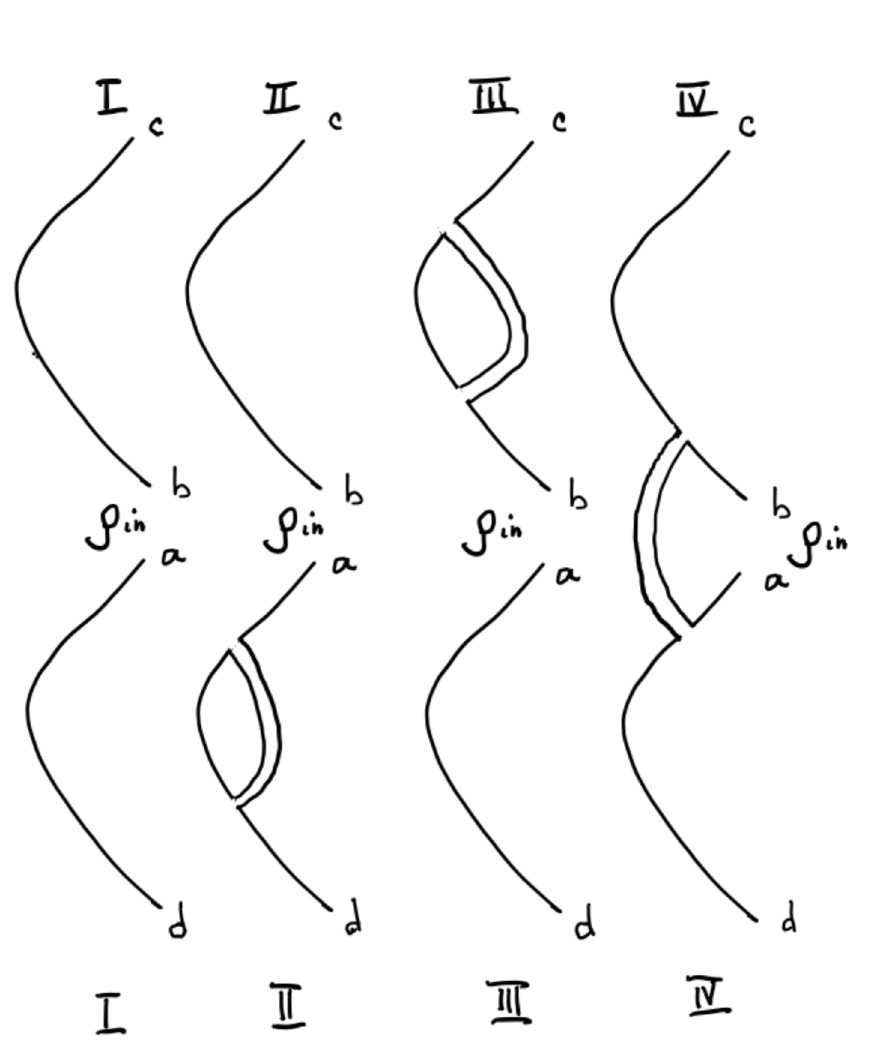
Figure 2 . The Feynman diagrams corresponding to the corrections to the evolution operator for the density matrix wich take into account the interaction of the heavy quark with massless vector and scalar particles, for order g 2 are depicted in fat graph notation. The initial density matrix is YM at the center and it has colour indices a; b . The reduced out-going density matrix has the indices d; c . Diagram I is the tree-level, diagrams II and III depict the correction to the amplitude coming from the self-interaction of the heavy quark, mediated by exchanging massless vector and scalar (cid:12)elds, and diagram IV is the correction to the reduced density matrix arising from tracing out the vector and scalar particles that are produced. In terms of colour indices, contributions I, II and III have the structure (cid:24) (cid:14) ad (cid:14) bc whereas IV has the structure (cid:24) (cid:14) ab (cid:14) cd .